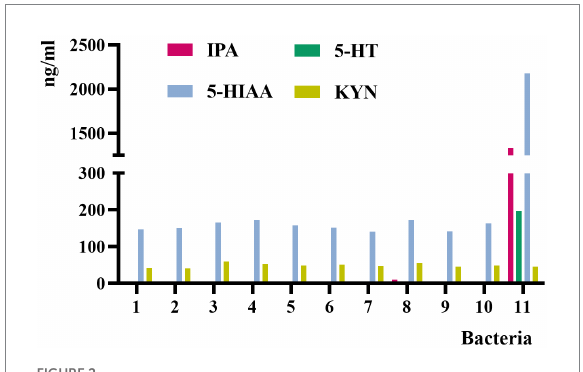
FIGURE 2 Concentrations of IPA, 5-HT, 5-HIAA, and KYN in the culture medium of 11 bacterial strains. 1, Enterobacter hormaechei ; 2, Enterobacter cloacae ; 3, Klebsiella pneumoniae ; 4, Escherichia fergusonii ; 5, Weissella confusa ; 6, Klebsiella michiganensis ; 7, Shigella flexneri ; 8, Shigella sonnei ; 9, Klebsiella singaporensis ; 10, Proteus columbae ; 11, Clostridium sporogenes .